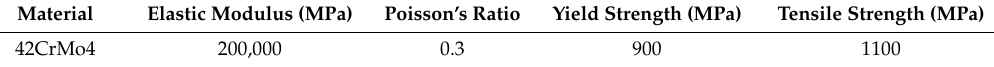
Figure 7. Boundary condition of bolted joint model. Table 2. Material properties of insert, bolt, and nut.